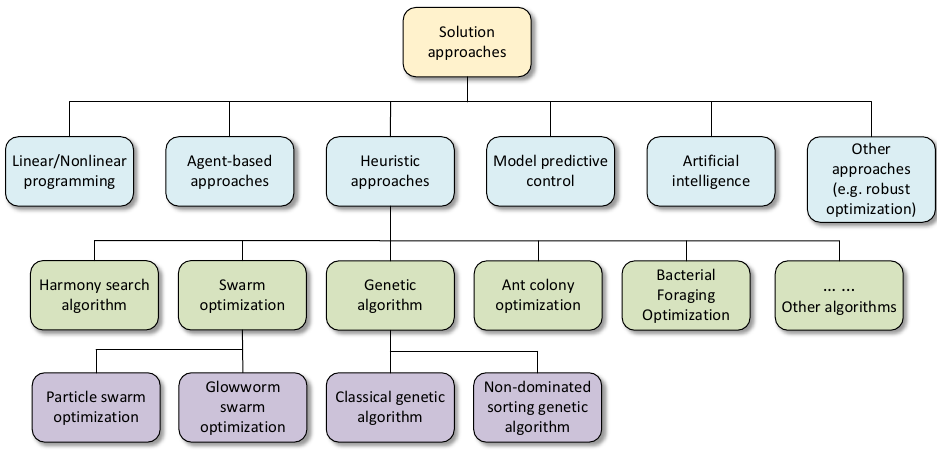
Figure 6. Commonly used solution approaches.